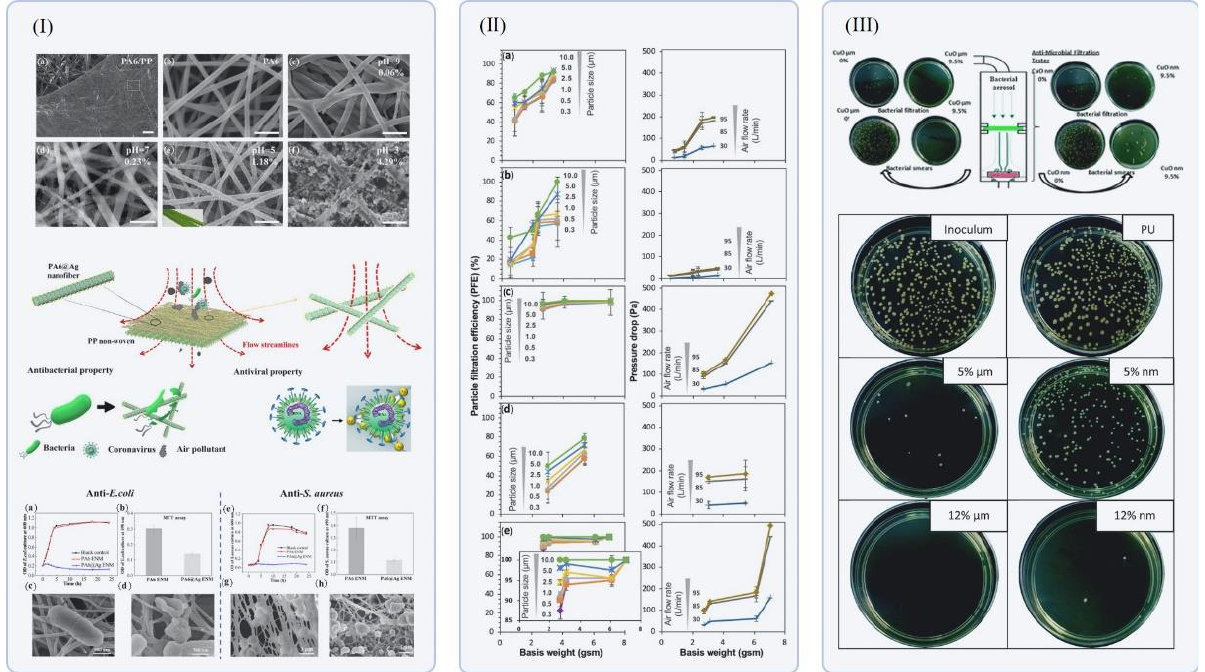
Figure 7. (I) Schematics showing antibacterial activity against E. coli ( a , b ) and the morphology ( c , d ) of these bacteria on PA6 electrospun nanofibers without and with Ag NPs, respectively; as well as the results obtained regarding their antibacterial activity against S. aureus ( e , f ) and the morphology ( c , d ) of these bacteria on PA6 nanofibers without and with Ag NPs ( g , h ), respectively. Adapted with permission from [48]. ( II ) Evaluation of electrospun nanofibers on particle filtration efficiency of ( a ) PAN, ( b ) PAN/PVDF, ( c ) PAN/PVDF/GM, ( d ) PAN/PVDF/Ag and ( e ) PAN/PVDF/GM/Ag. Adapted with permission from [98]. ( III ) Schematic representation of antibacterial activity evaluation of polyurethane nanofibers incorporating CuO NPs against Staphylococcus gallinarum. Adapted with permission from [97].